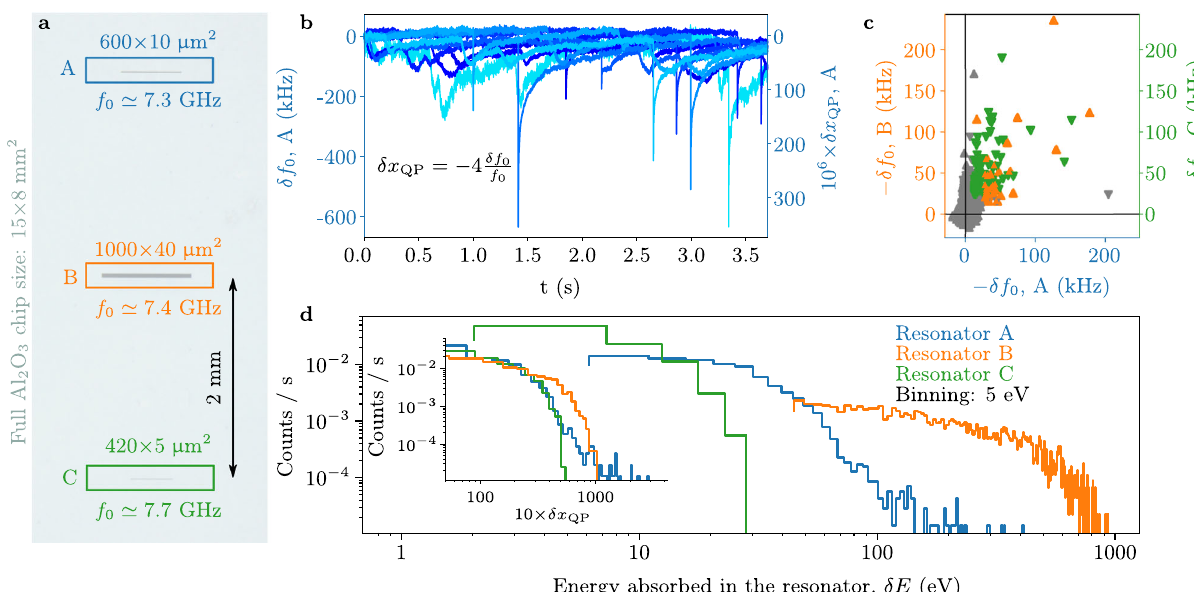
Fig. 1 Quasiparticle bursts and deposited energy in grAl resonators. a False-colored photograph of the central part of the sapphire chip, supporting three 20 nm thick grAl resonators, labeled A, B, and C. b Overlay of ten measured time traces for the resonant frequency shift δ f 0 of resonator A. Similarly to refs. 10,21,36 , quasiparticle (QP) bursts appear as sudden drops, given by the sharp rise in kinetic inductance, followed by a relaxation tail. The y -axis on the right-hand side shows the corresponding fractional quasiparticle density shift δ x QP = − 4 δ f 0 / f 0 . We identify a QP burst by applying a derivative fi lter, triggering only on sharp rises in the baseline. For clarity, the shown traces are selected to contain a QP burst; on average, only one trace in ten contains a QP burst. To highlight the fact that QP bursts are correlated in time, in c , we plot the measured frequency shifts of resonator B (upward triangles) and C (downward triangles) versus the frequency shift of resonator A. Colored markers correspond to values above threshold, with the threshold de fi ned as two standard deviations of the baseline fl uctuations (cf. Supplementary Information). Therefore, each colored marker depicts a time-correlated QP burst between resonators A – B (orange) and A – C (green). d Estimated distribution of the energy absorbed in the resonators δ E = δ x QP Δ grAl n CP V , calculated from the measured δ x QP shown in the inset, where Δ grAl ≃ 300 μ eV is the grAl superconducting gap, and n CP = 4 × 10 6 μ m − 3 is the volume density of Cooper pairs, and V is the volume of each resonator. For each burst, the energy deposited in the substrate is estimated to be 10 3 – 10 4 times greater than δ E (cf. Supplementary Information). The total QP burst rate Γ B is obtained by counting all bursts above the common threshold δ x QP = 5 × 10 − 5